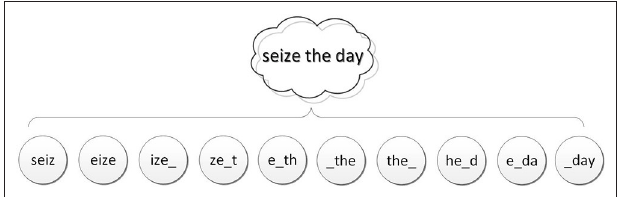
FIGURE 2 | 4-Gram node construction of the sentence “seize the